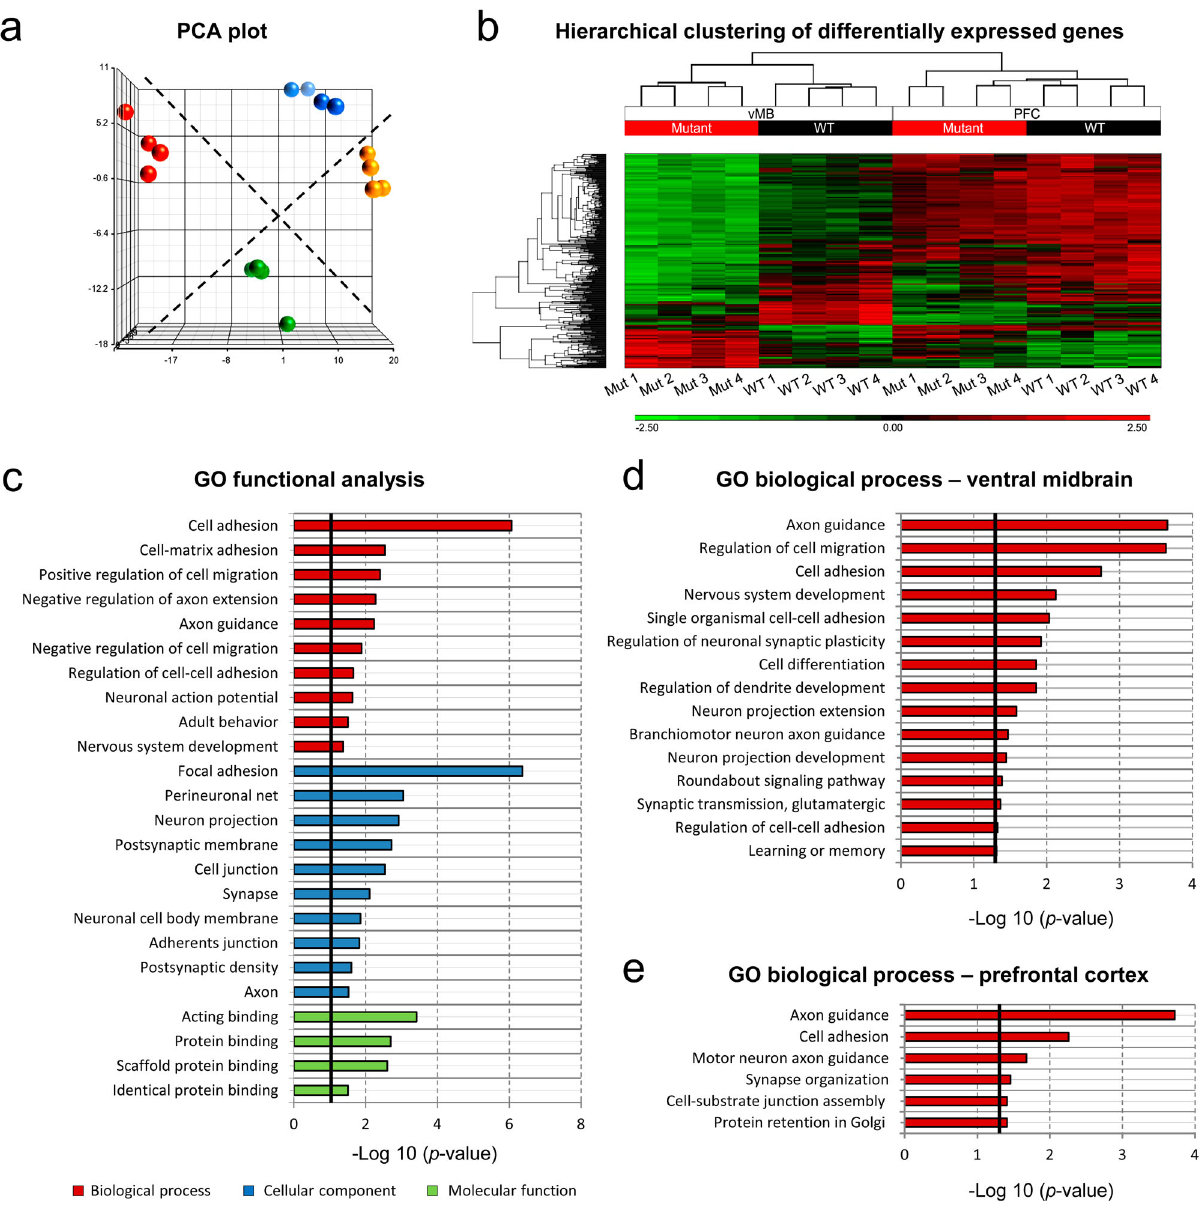
Fig. 8 Whole-transcriptome analysis. a PCA plot, demonstrating hierarchical clustering of WT and Cdh2 H150Y mice ( n = 16, four samples per tissue per genotype), extracted from both the PFC (blue and yellow spheres, respectively) and vMB (red and green spheres, respectively) tissue samples. b Heatmap of DEGs clustering for PFC and vMB RNA-seq data. c GO term enrichment analysis of 416 DEGs from vMB and PFC using the DAVID functional annotation tool (https://david.ncifcrf.gov/summary.jsp/). The DAVID Functional Annotation Clustering function uses a Kappa statistic score to measure relationships among the annotation terms based on the degrees of their co-association genes. The most signi fi cantly relevant GO terms in biological process (red), cellular component (blue), and molecular function (green) branches are presented. All statistically signi fi cant values of the terms were negative 10-base log-transformed. The vertical black line delineates the signi fi cance threshold (corresponding to p -value = 0.05). d , e GO analysis using DAVID functional annotation tool, presenting the most signi fi cant relevant terms in the biological process domain for ( d ) 604 vMB DEGs and ( e ) 181 PFC DEGs. One-sided p- values for Modi fi ed Fisher ’ s Exact test are de fi ned. PCA, Principal component analysis; PFC, prefrontal cortex; vMB, ventral midbrain; DEGs, differentially expressed genes; GO, Gene Ontology; DAVID, Database for Annotation, Visualization and Integrated